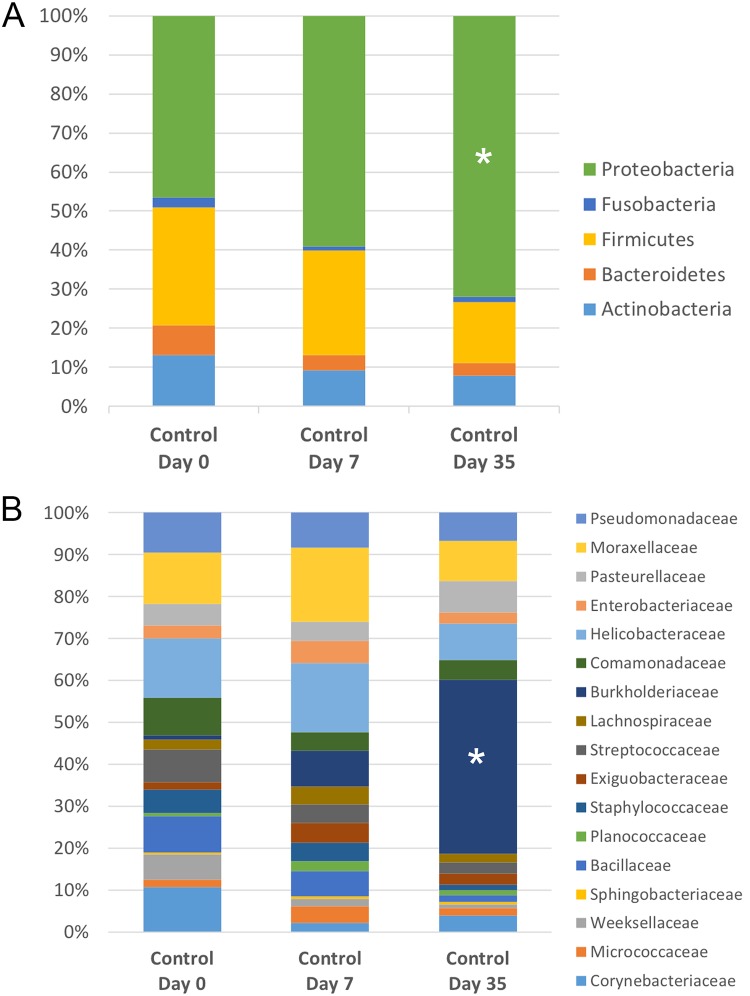
Temporal composition by bacterial phyla (A) and families (B) in control eyes.Bars represent mean percentage of taxa present at ≥ 3% mean relative abundance. (A) Note the relative abundance of Proteobacteria (*) is increased on day 35, and (B) the relative abundance of Burkholderiacaea (*) is increased on day 35.